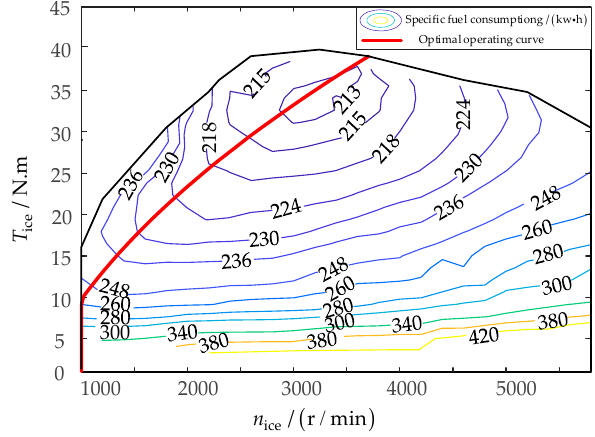
Figure 12. Specific fuel consumption map of the ICE.